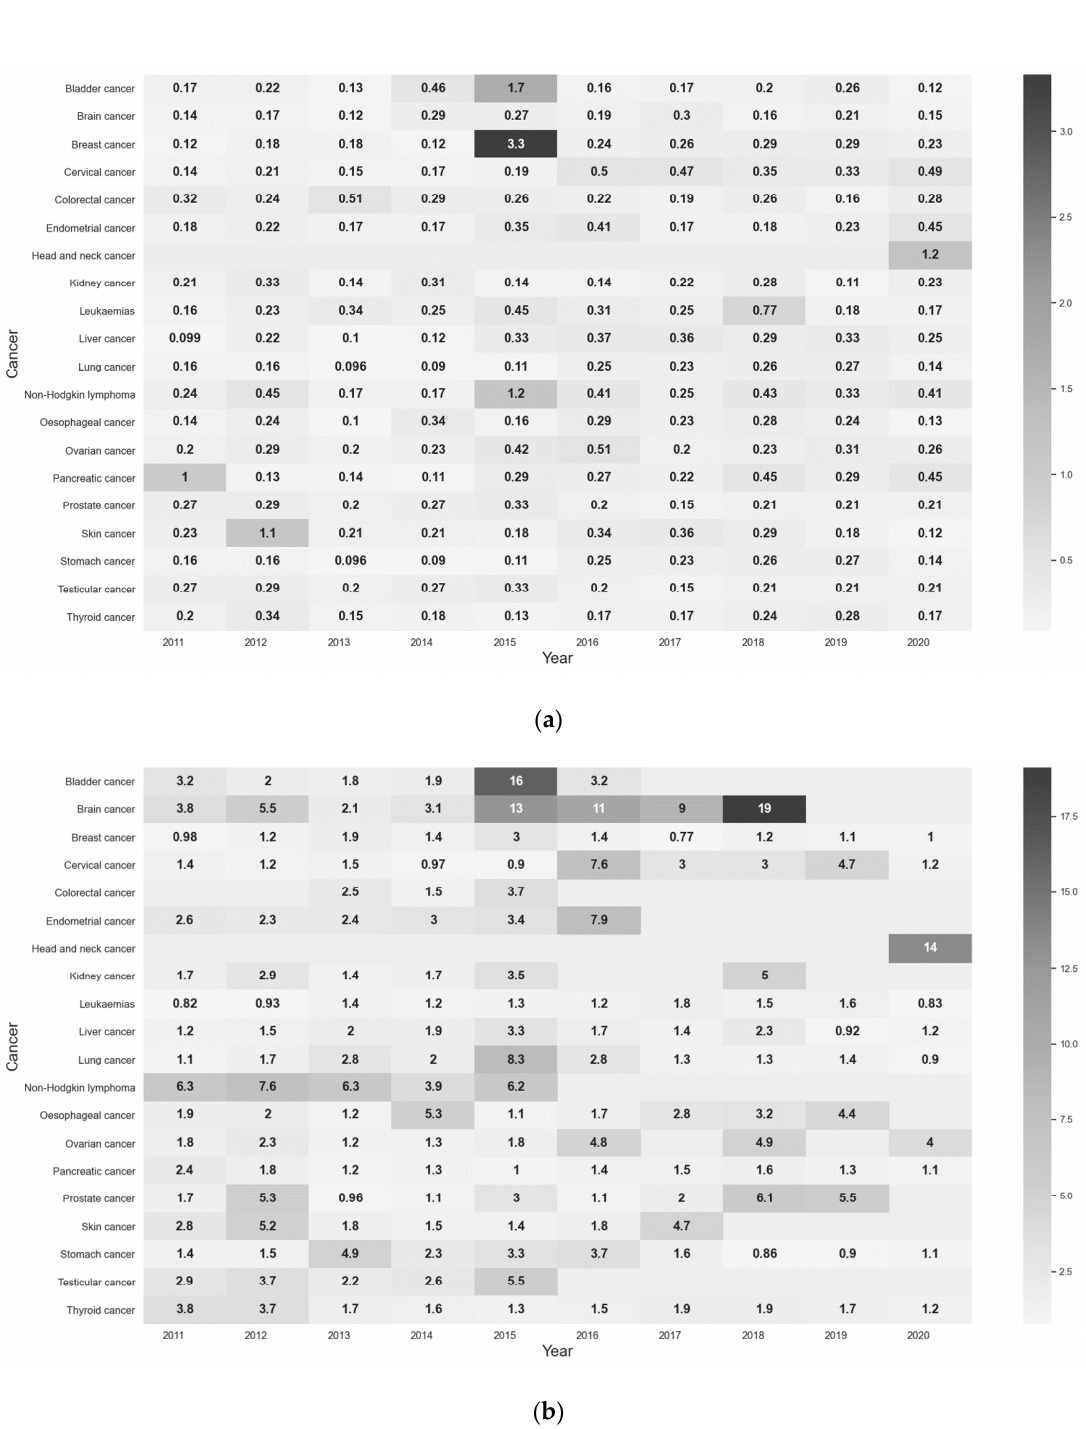
Figure 4. ( a ) Description of yearly CV of the Baidu Search Index among 20 cancers; ( b ) Description of yearly CV of the Baidu Media Index among 20